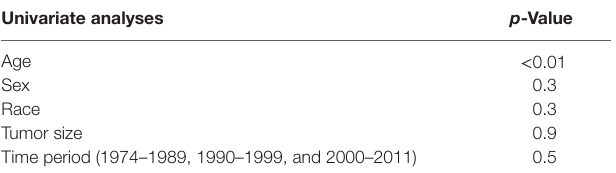
TaBle 3 | Factors associated with surgery.